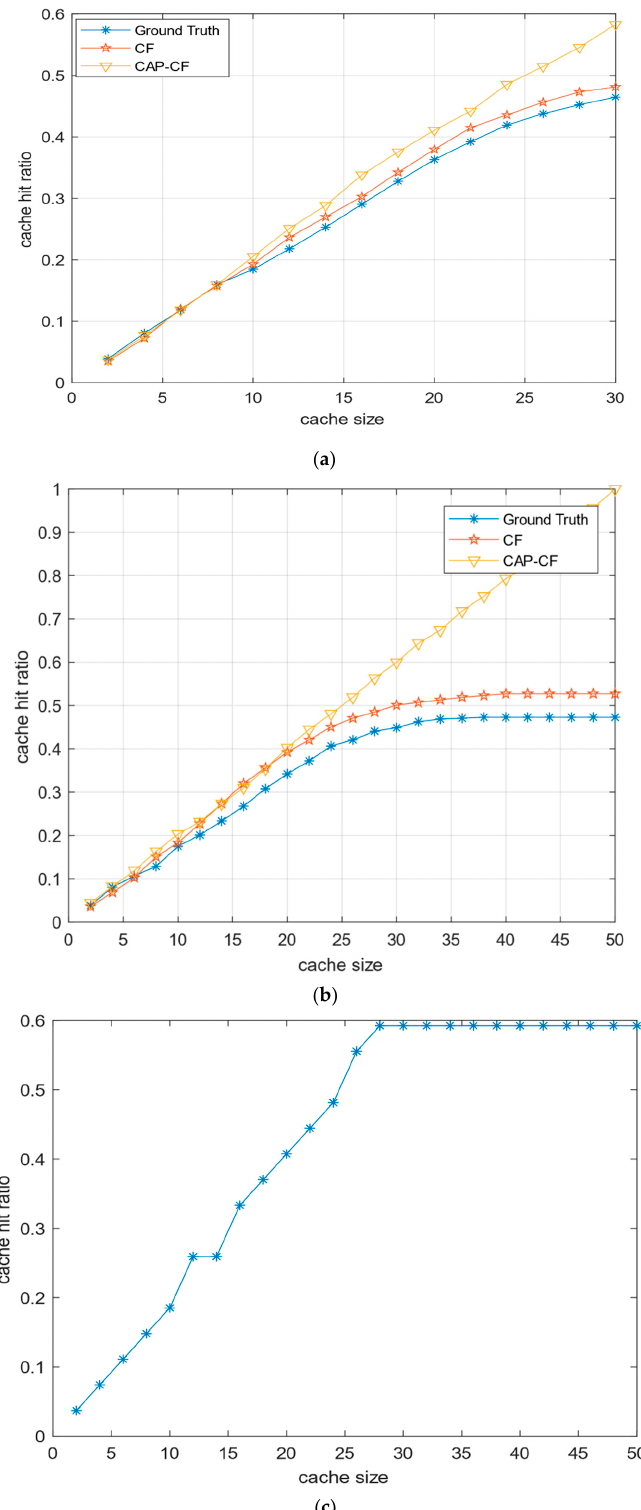
Figure 3. ( a ) Cache hit ratio versus cache capacity of pico cells. ( b ) Cache hit ratio versus cache capacity of micro cells. ( c ) Cache hit ratio versus cache capacity of macro cells.